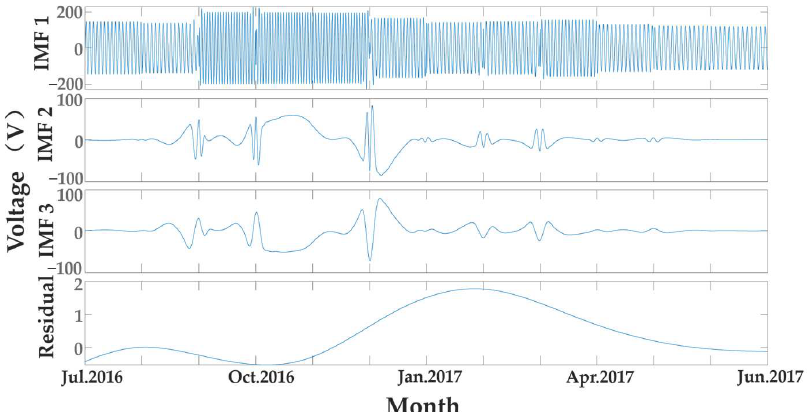
Figure 12. EMD decomposition of the annual generation waveform of tidal power.